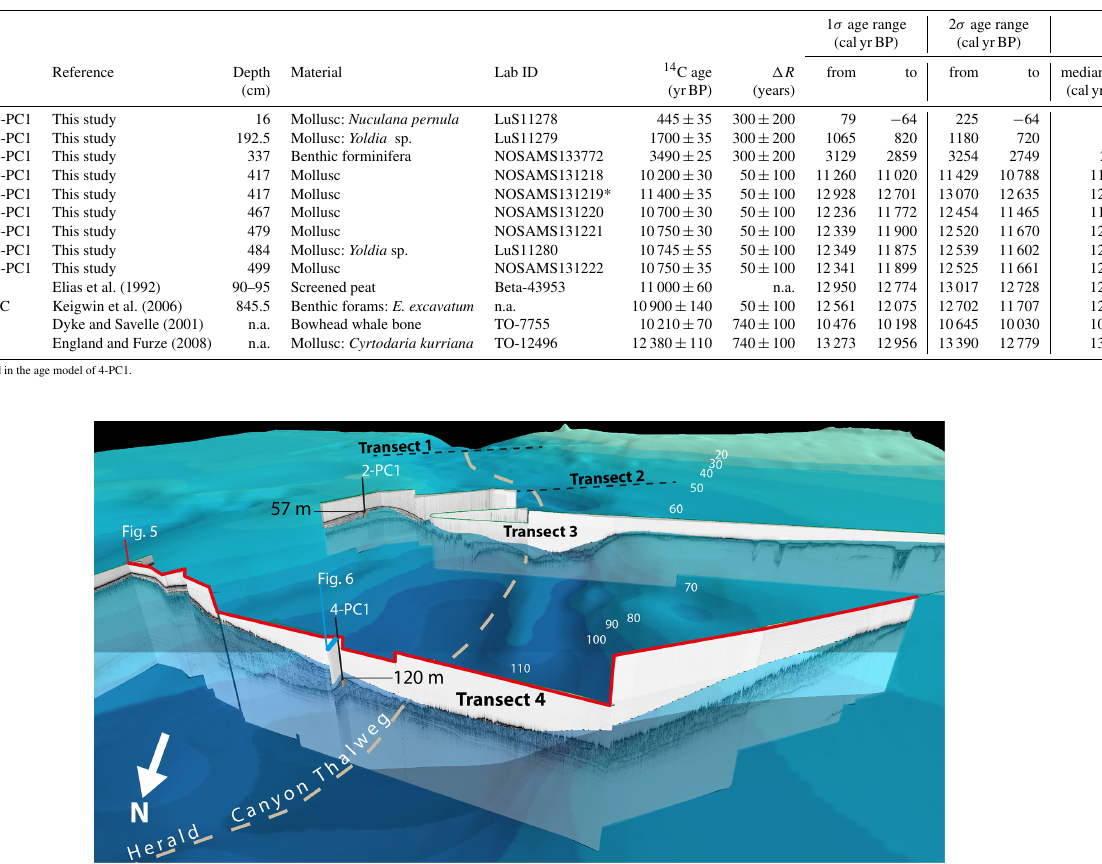
Table 1. AMS radiocarbon ages and calibrations for core 4-PC1 and literature dates constraining the Beringia flooding. All ages are calibrated with the Marine13 (Reimer et al., 2013) radiocarbon calibration curve, except for beta-43953 (Elias et al., 1992), which is calibrated using IntCal13 (Reimer et al., 2013).